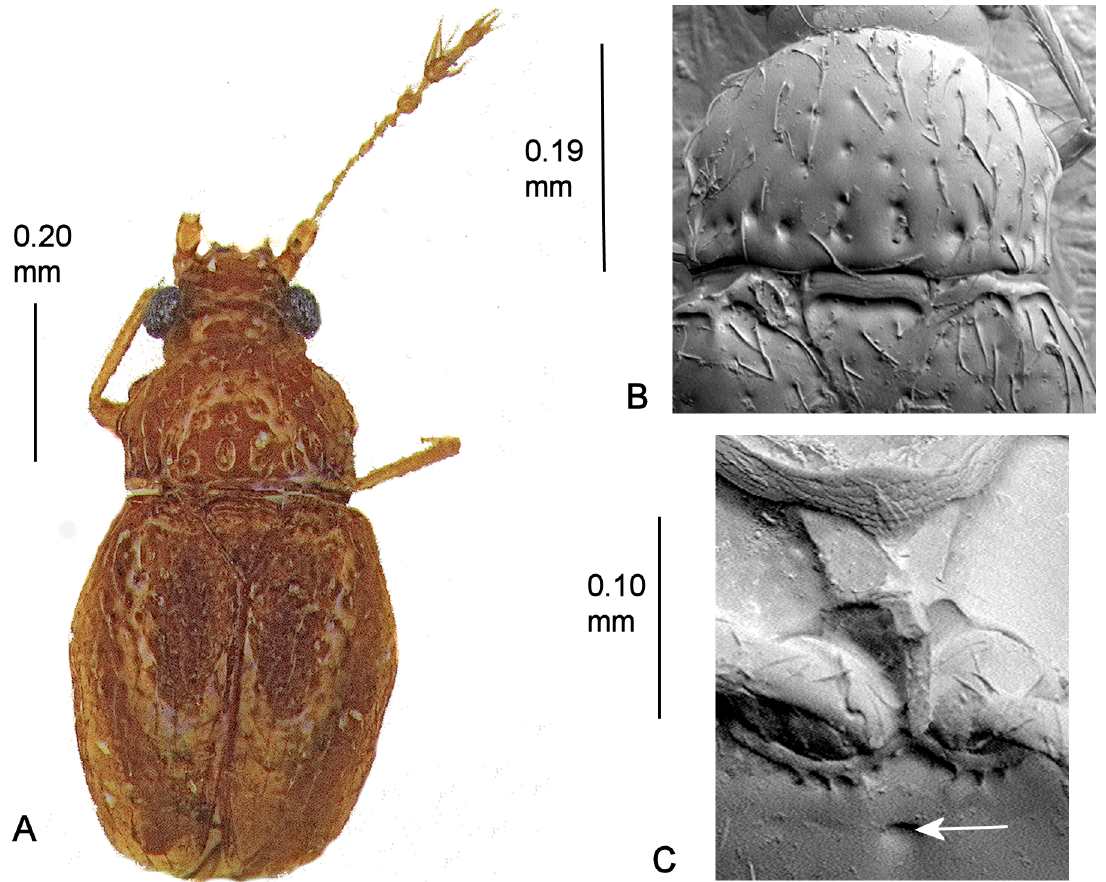
Fig. 110. Cissidium kolombangaricum sp. nov. A . Habitus. B . Pronotum, × 425. C . Mesoventrite showing median process of collar, mid-keel and keel, ×